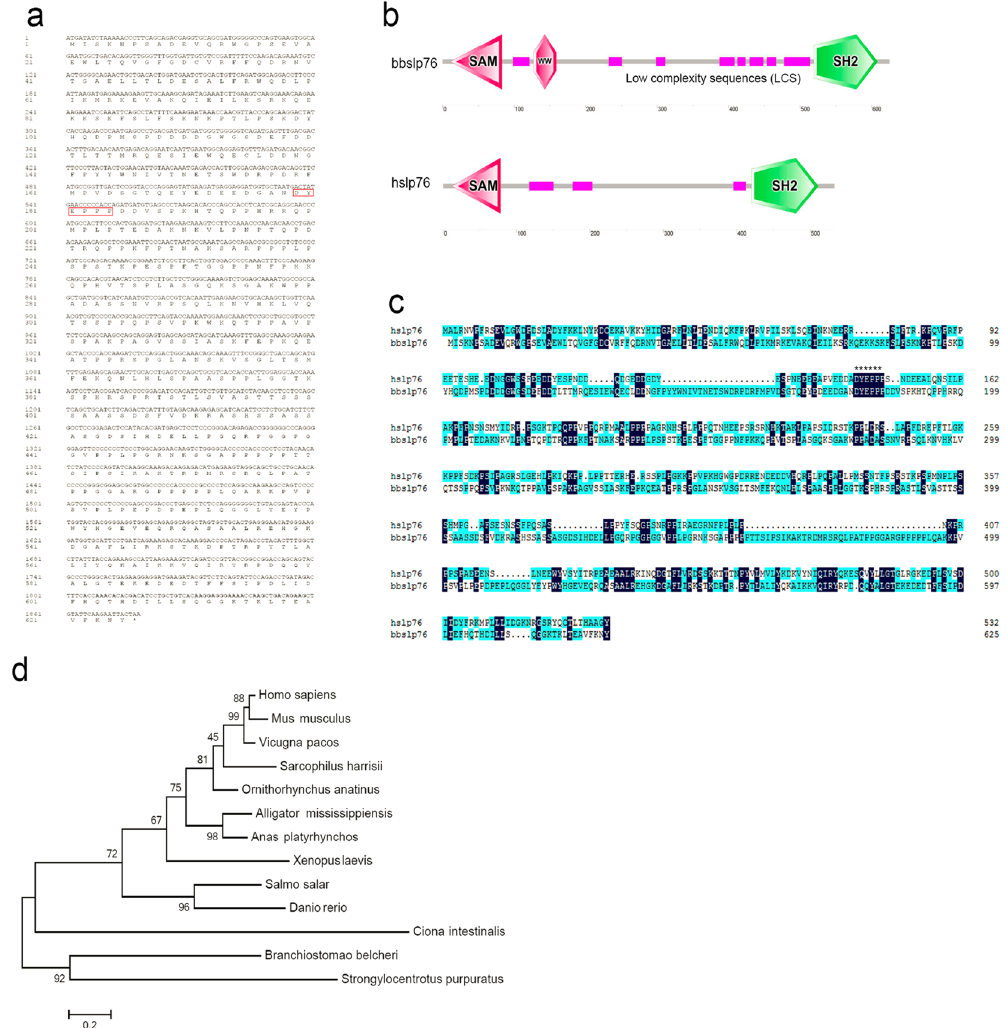
Figure 1. Sequence and phylogeny tree of bbslp76. ( a ) Nucleotide and amino acid sequence of bbslp76. Itk binding motif DYEPPP was marked in the red frame. ( b ) Protein structures of bbslp76 and hslp76 generated by SMART. ( c ) Sequences alignment of bbslp76 and hslp76. The color of Sky blue represents 50% consensus of amino acid and dark blue represents 100% consensus of amino acid. Itk binding motif DYEPPP motif was highlight with ****** . ( d ) Phylogenetic tree of slp76. The neighbor-joining phylogenetic tree was constructed on the basis of 13 different slp76 sequences from GenBank, utilizing the sequence analysis tool MEGA